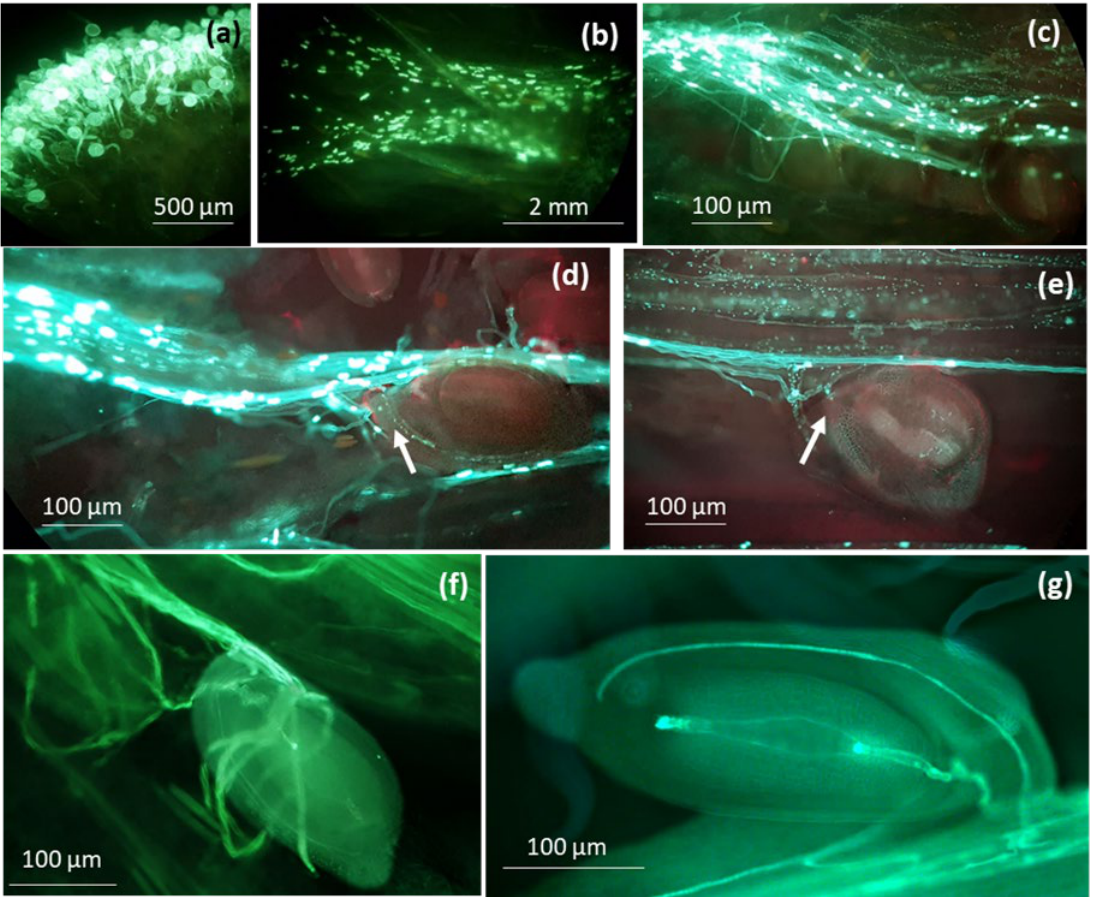
Figure 2: Fluorescence aniline blue staining of self-pollen tube in L-morph pistils (a-f). a) Pollen grains germination on a stigma surface (zoom 10X); b) Pollen tubes elongating in a style (zoom 2.5X); c, d, e) Pollen tubes in the ovarian area (zoom 20X); f) Pollen tubes in the area of embryo sac (noticed for 6 pollen tubes over 300 studied). g) Pollen tubes in the area of embryo sac in S-morph ovary after self-